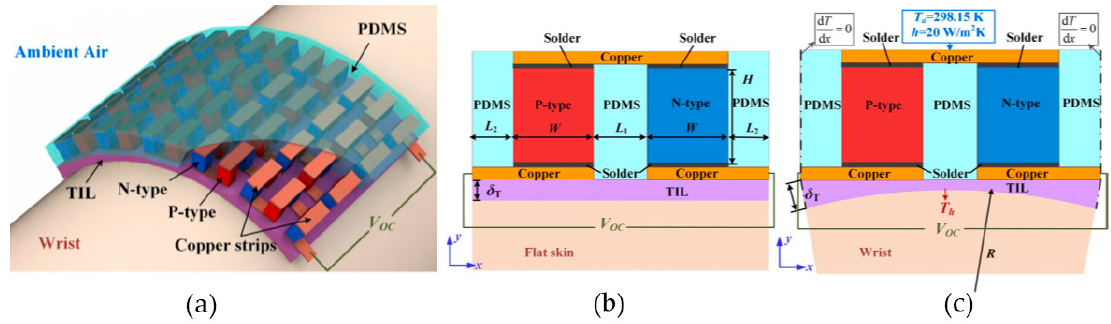
Figure 21. ( a ) Structural design of a wearable TEG on the wrist; ( b ) cross-sectional view of the TEG on skin that is a flat surface and ( c ) on skin that is a curved surface [112].